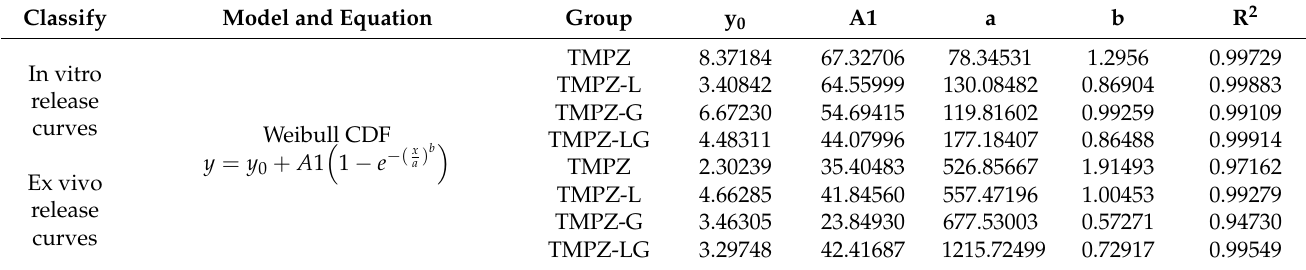
Figure 4. Fitting of release curve drawn by origin software. ( A ) Fitting of release curve across the dialysis membrane by Weibull CDF model. ( B ) Fitting of transdermal release curve by Weibull CDF model. Table 1. Weibull CDF model fitting of release curves for TMPZ, TMPZ-L, TMPZ-G and